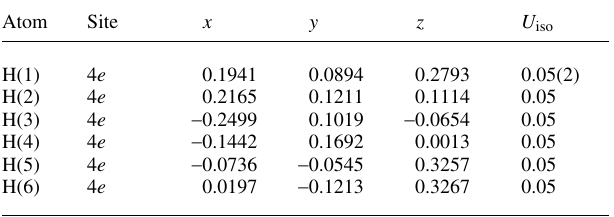
Table 11. Atomic coordinates and displacement parameters (in Å 2 ) . Table 10. Data collection and handling.